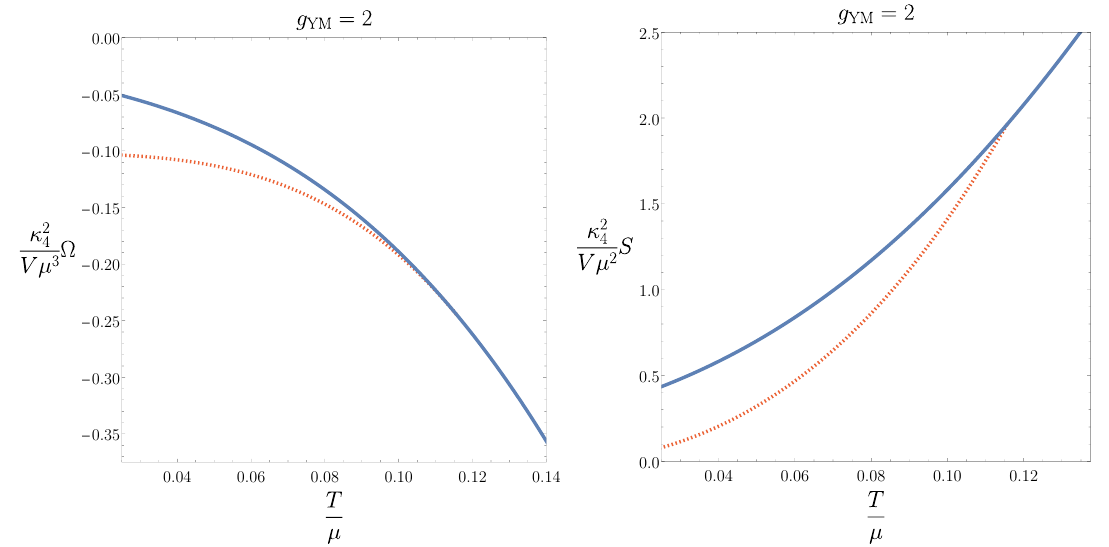
Figure 10. The grand potential Ω as a function Figure 11. The entropy S as a function of of temperature for both normal and condensed temperature for both normal (blue) and con- phase with g YM = 2 . The red dashed curve (con- densed phase (red, dashed) with g YM = 2 . At densed phase, h J x i 6 = 0 ) and the blue curve (nor- T = T c , the red curve is continuous but non- 1 mal phase, h J x i = 0 ) smoothly intersect showing differentiable. The behaviour exhibited is there- 1 that Ω is both continuous and differentiable. fore that of second order phase